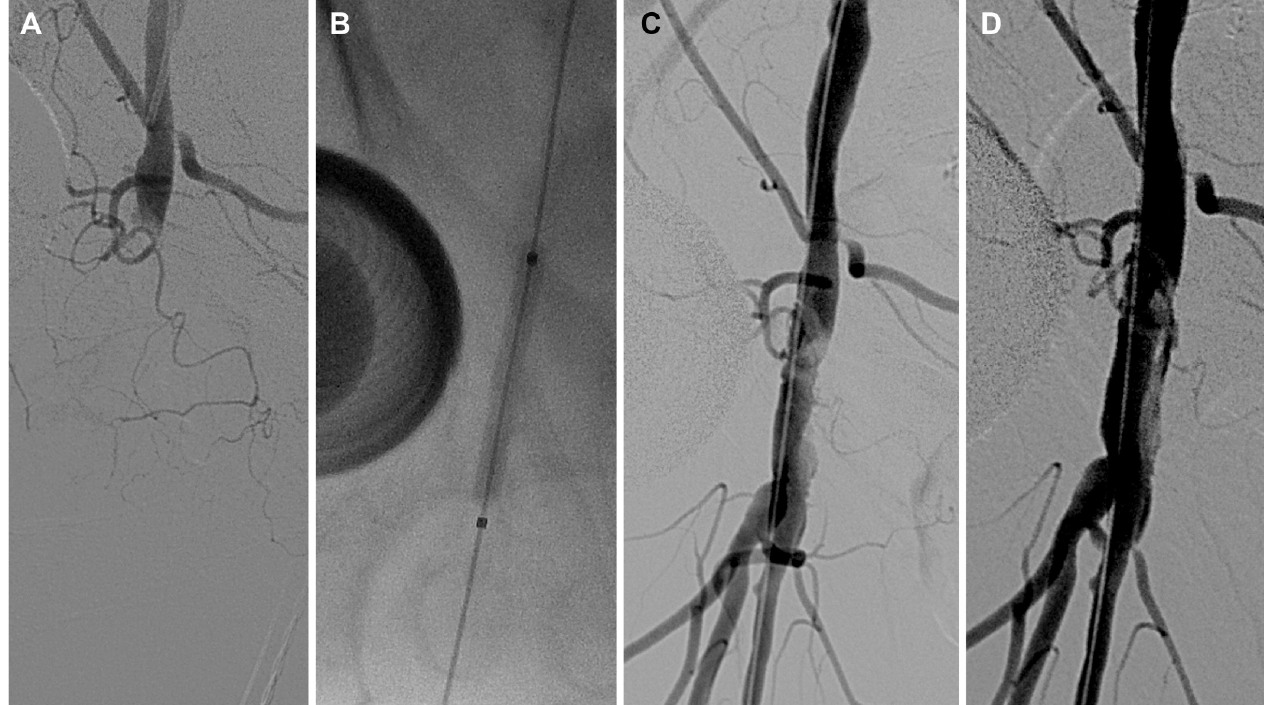
Fig 4. A 70-year-old woman developed acute ischemia of the right leg after percutaneous coronary intervention. (a) Total occlusion of the common femoral artery was revealed with angiography using a contralateral femoral approach. (b, c) Prolonged inflation of an angioplasty balloon was performed. (d) After completion, angiography revealed revascularization of the common femoral artery with a non-flow-limiting intimal dissection. The superficial and deep femoral arteries demonstrated patency, and stenting was not